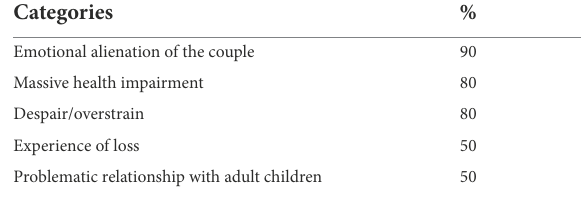
TABLE 1 Overview of the topics mentioned by the men and women at the beginning of counseling. Percentage of mention of this problem for N =